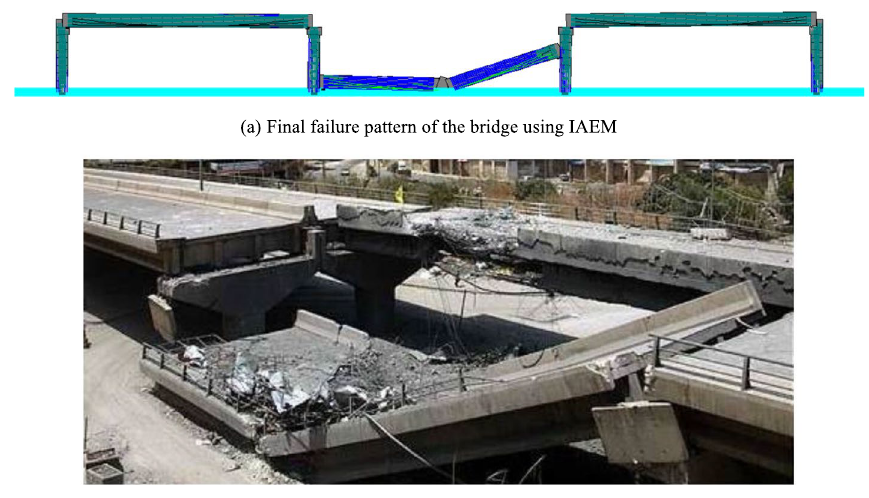
Fig. 12 Collapse of a prestressed bridge due to blast